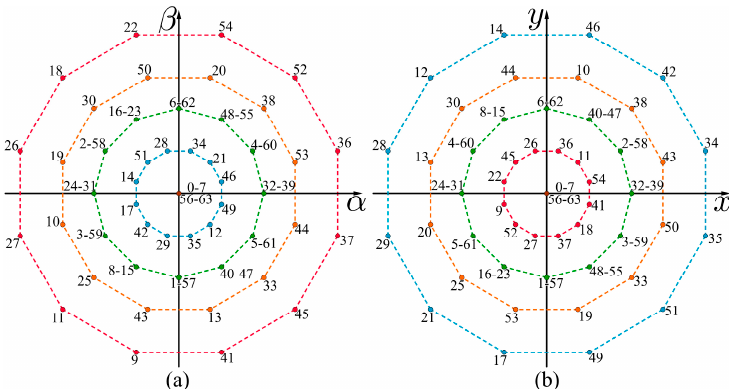
Figure 2. Voltage vectors in the α - β (( a ) plots) and x-y (( b ) plots) subspaces for an asymmetrical six-phase IM.